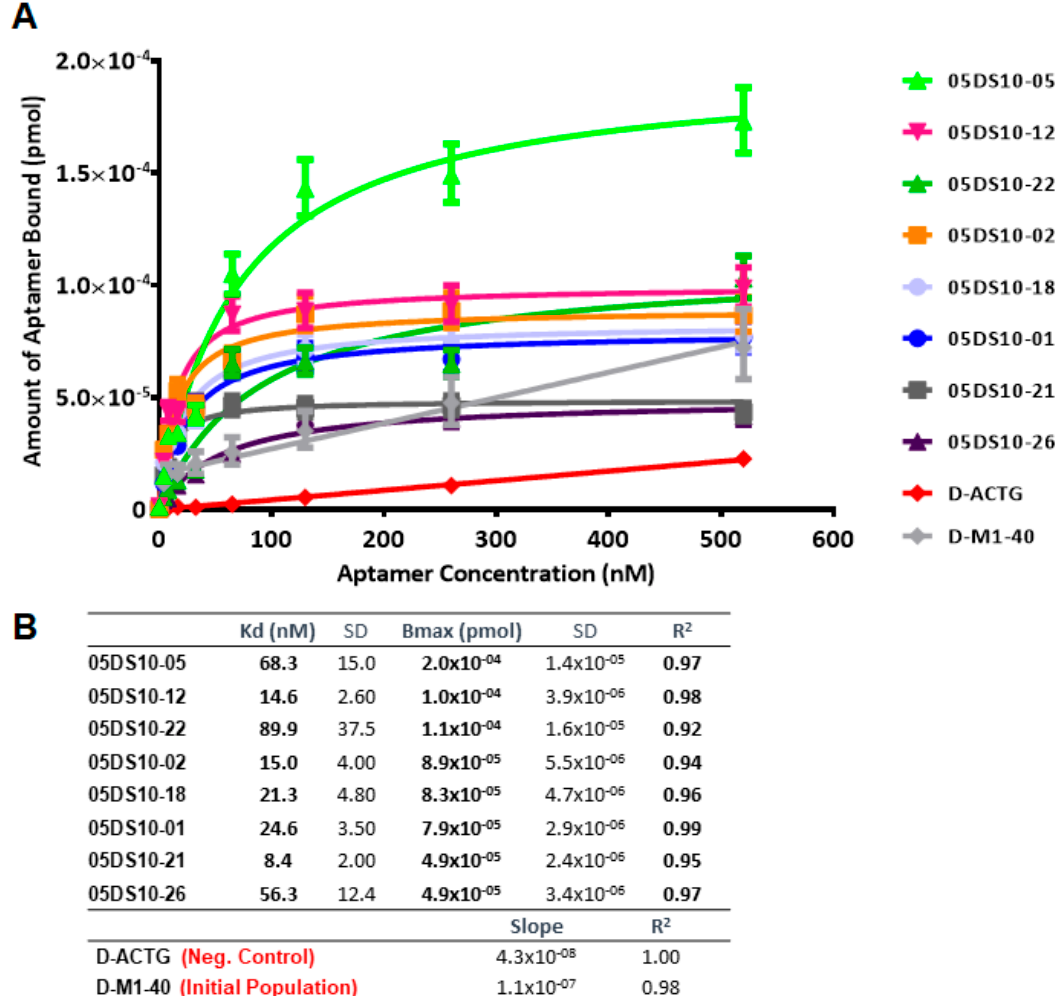
Figure 5. Characterization of the high affinity ssDNA individual aptamers present in the last SELEX round, by means of ELONA-qPCR. The affinity curves obtained for the eight selected individual aptamers ( A ) showed that the best fit curve corresponded to a one site-specific binding model (with R 2 values in the range of 0.92–0.99) in all cases, from which the Kd and Bmax values were derived ( B ). In parallel, both the D-ACTG molecule used as a negative control and the initial population of D-M1-40 (see text for details) could only be adjusted to a linear regression model, thus showing non-specific binding to PCBP-2.